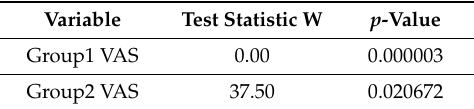
Table 11. Results of Wilcoxon signed-ranks tests.